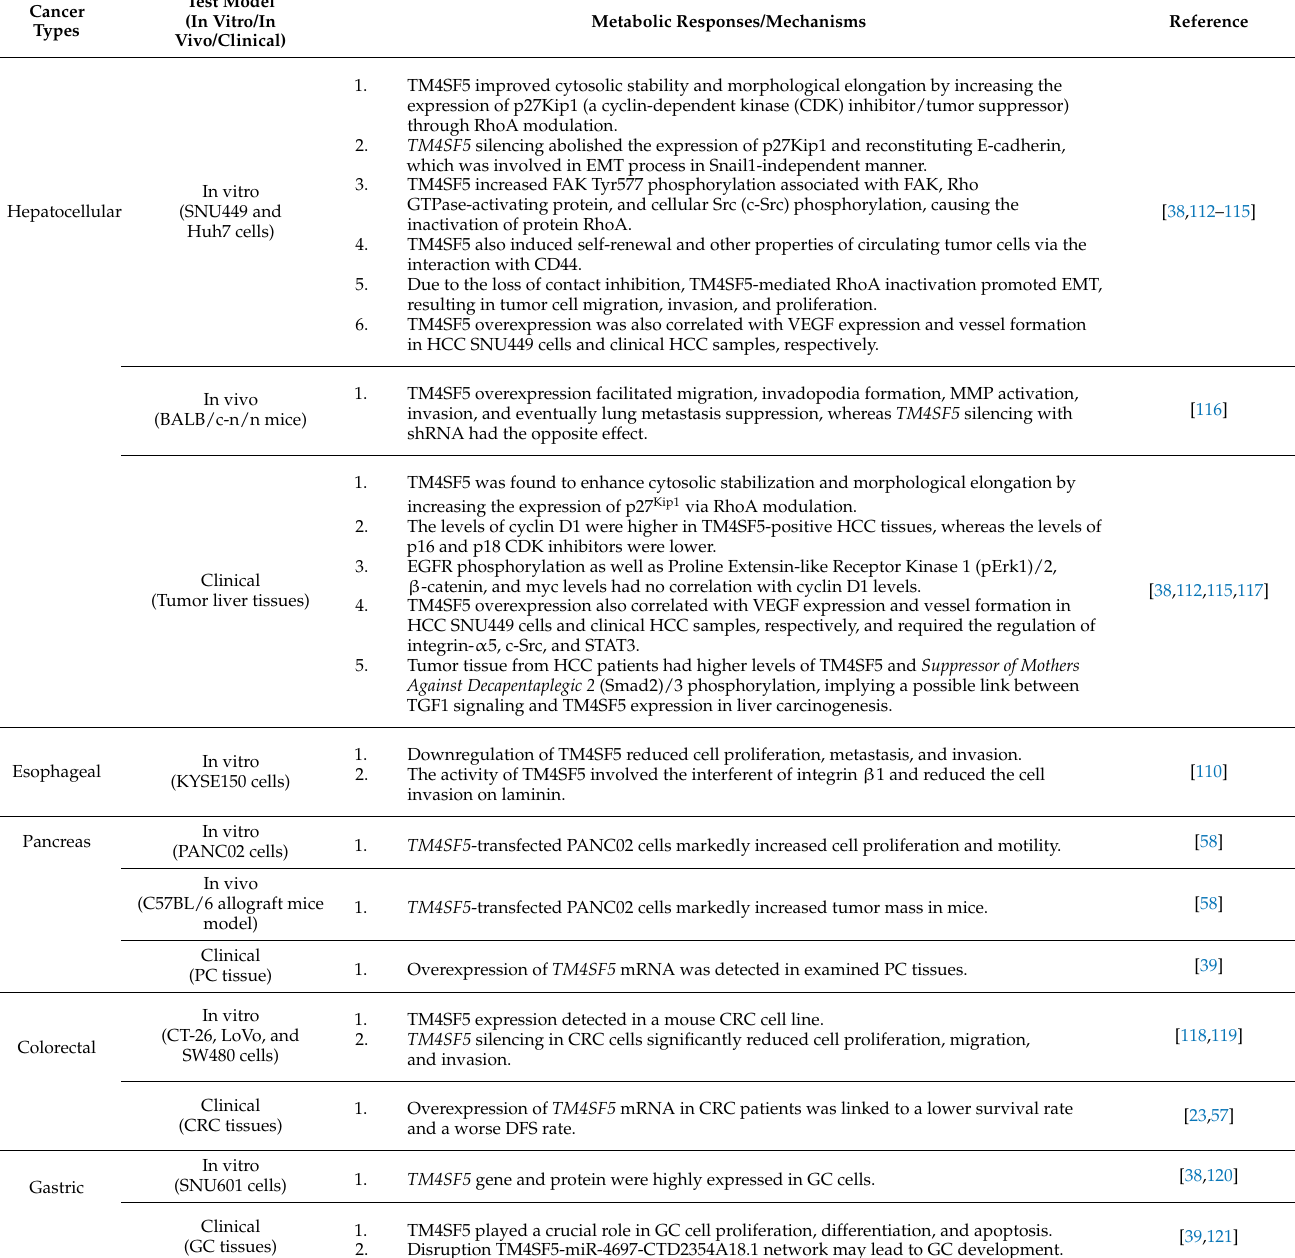
Table 3. Molecular expression, regulatory roles, biomolecular interactions of TM4SF5 in different cancers, and the underlying mechanism of actions against cancer phenotypes and